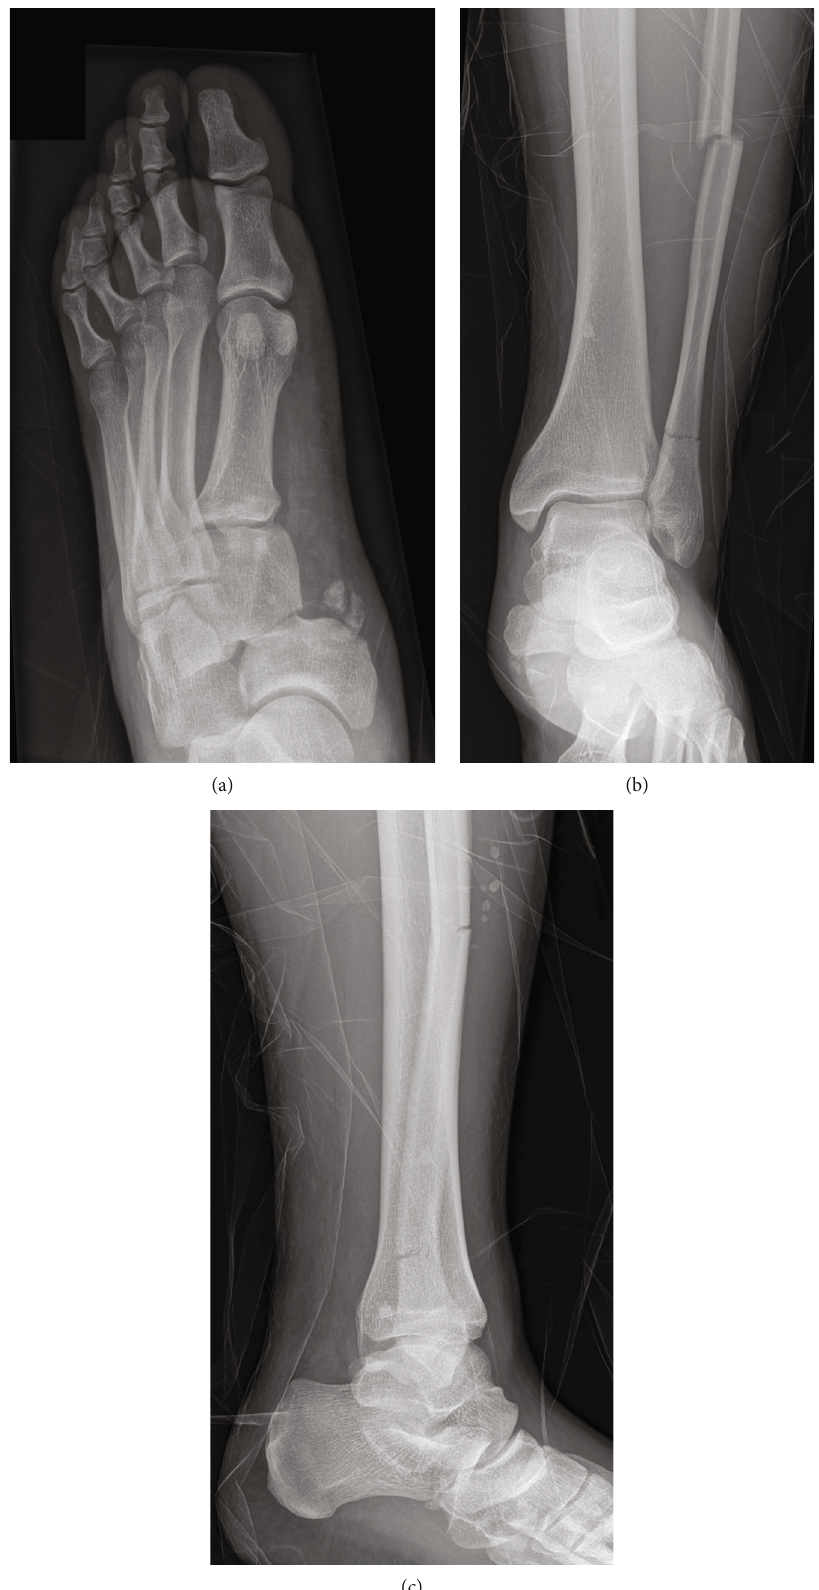
Figure 1: (a) Anteroposterior X-rays of the left foot show a dislocation through the naviculocuneiform joint with bony avulsions. (b) Frontal and (c) lateral X-rays of the ankle show a bifocal fracture of the fi